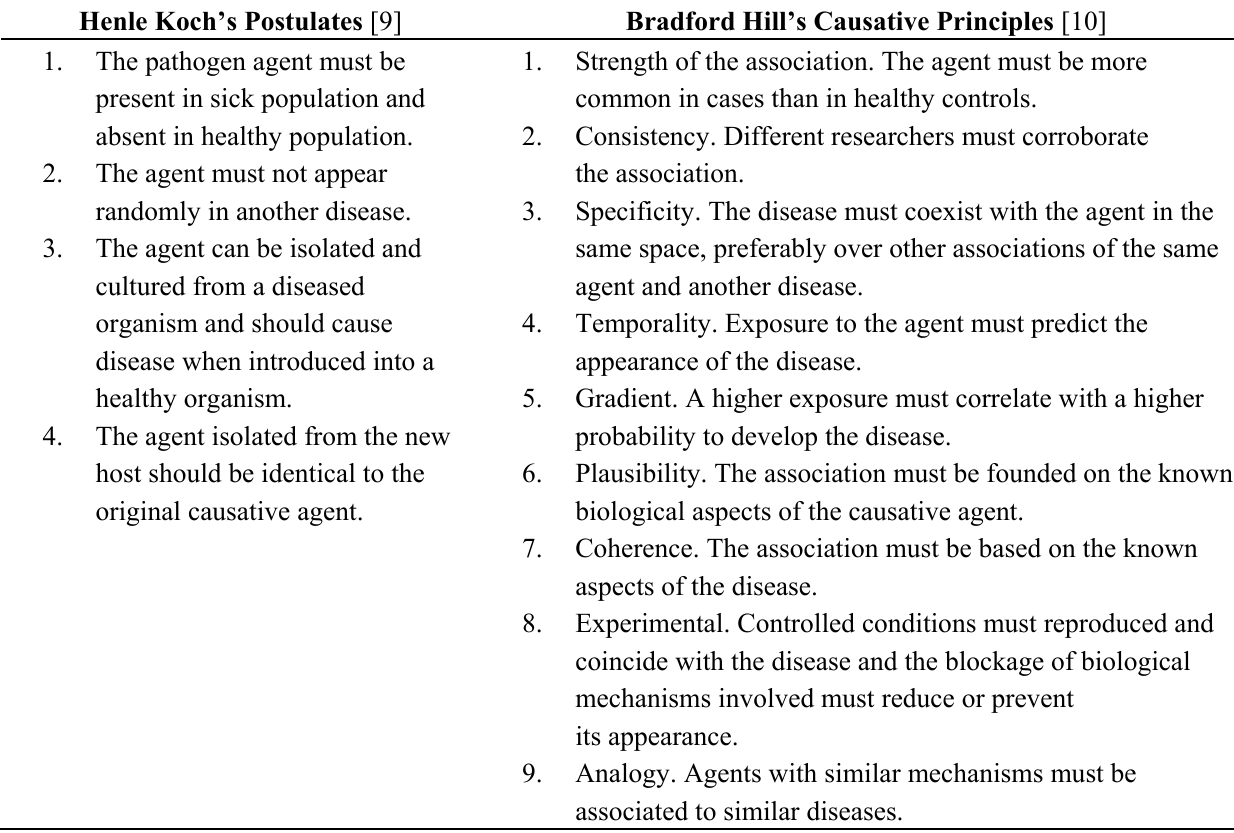
Table 1. Koch and Bradford Hill’s postulates for causative